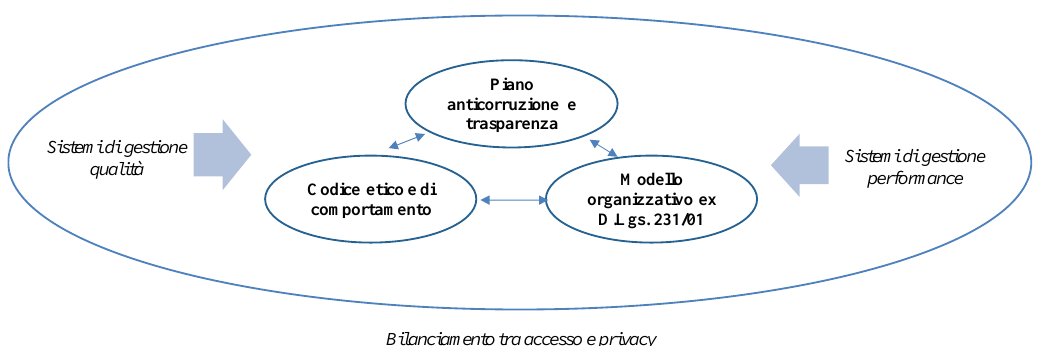
Figure 1: Integrated Control